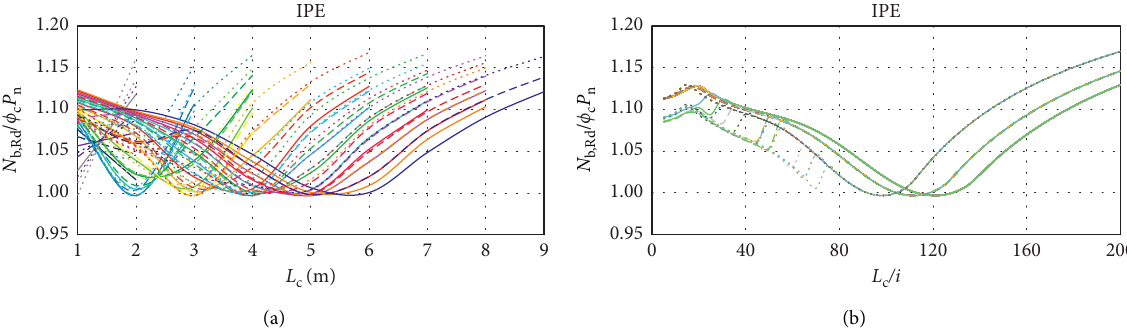
Figure 9: Variation of capacity ratio with buckling length L c (a) and with member slenderness L c / i (b) for studied IPE members. In each plot, the solid, dashed, and dotted curves with identical colours represent the capacity curves plotted for a particular section when the steel grades are S235, S275, and S355, respectively.